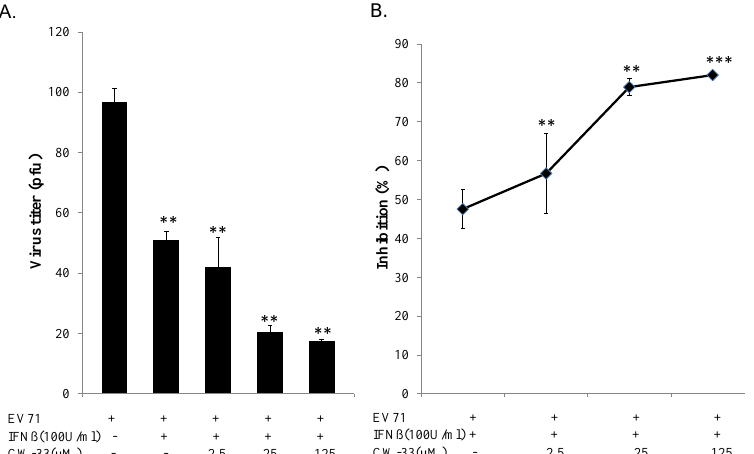
Figure 5. Inhibition of EV-A71 plaque formation by combined treatment of CW-33 with IFN-β. Monolayer of RD cells in 6-well plates infected with EV-A71 (100 pfu) was immediately treated with CW-33 alone or in combination with IFN-β. After 1-h absorption, cell monolayer was washed with PBS, then overlaid with medium containing 1.5% agar.